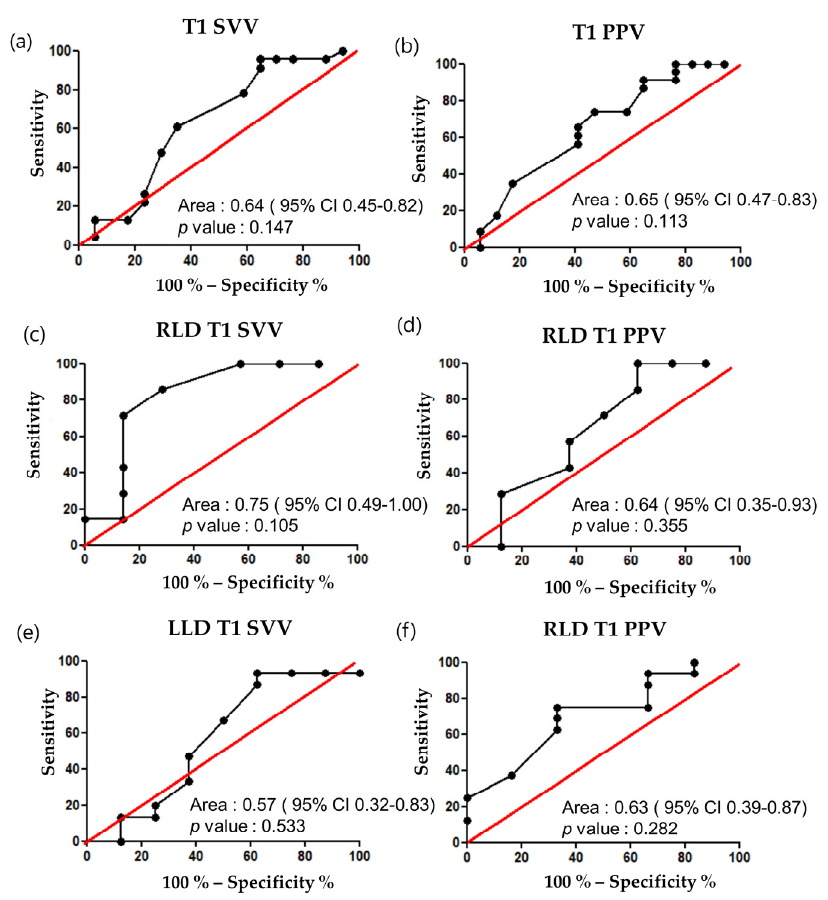
Figure 1. AUROC of dynamic indices before fluid challenge. ( a ) SVV; ( b ) PPV; ( c ) Right lateral decubitus SVV; ( d ) Right lateral decubitus PPV; ( e ) Left lateral decubitus SVV; ( f ) Left lateral decubitus PPV . Table 3. Relationship between indices and percent change in SVI. r p -Value T1 PPV 0.608 <0.001 T1 SVV 0.553 <0.001 PPV, pulse pressure variation; SVV, stroke volume variation.